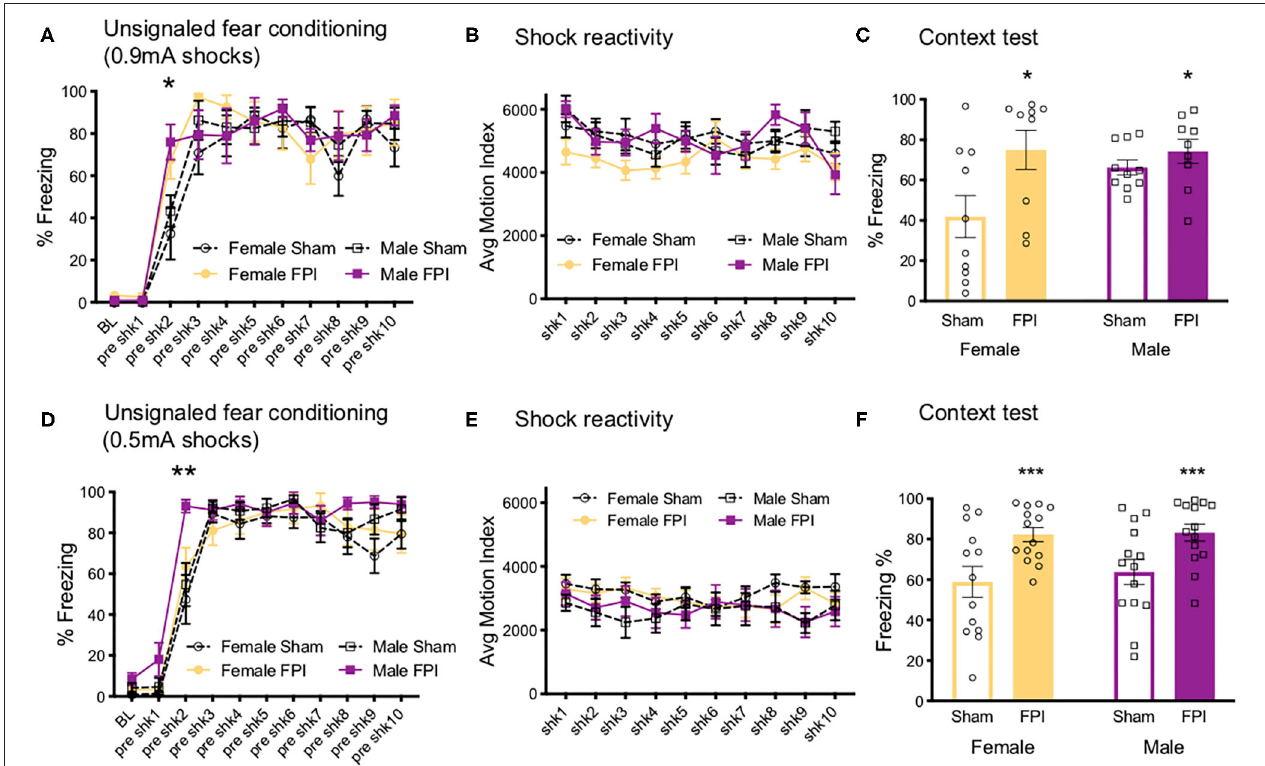
FIGURE 5 | Sex and FPI effects on strong and weak unsignaled (context) fear conditioning. (A) Fear acquisition across 10 strong (0.9mA) unsignaled footshocks. An injury × trial interaction revealed that FPI groups started freezing immediately following the first shock compared to sham (* p < 0.05 Sham vs. FPI). (B) No differences in shock reactivity during conditioning to 0.9mA shocks. (C) FPI groups displayed a significant increase in context fear when tested the next day (15min test; * p < 0.05 Sham vs. FPI). (D) Similar to 0.9mA shocks, FPI groups displayed an increase in freezing following the first footshock, even at a lower intensity at 0.5mA (** p < 0.01 vs. Sham). (E) No differences in shock reactivity during conditioning to 0.5mA shocks. (F) FPI groups showed elevated context fear compared to sham following weak unsignaled shock fear conditioning (*** p < 0.01 Sham vs. FPI). Data are represented as mean ± SEM; n =